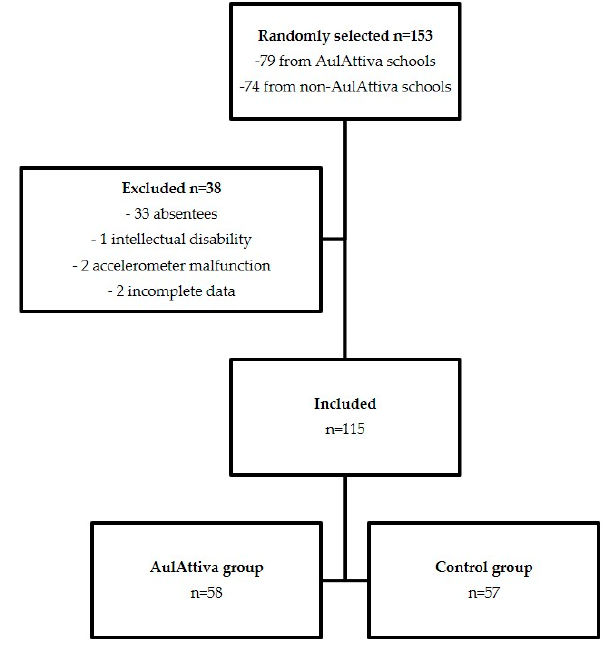
Figure 1. Flow chart of the selection of participants to the study.